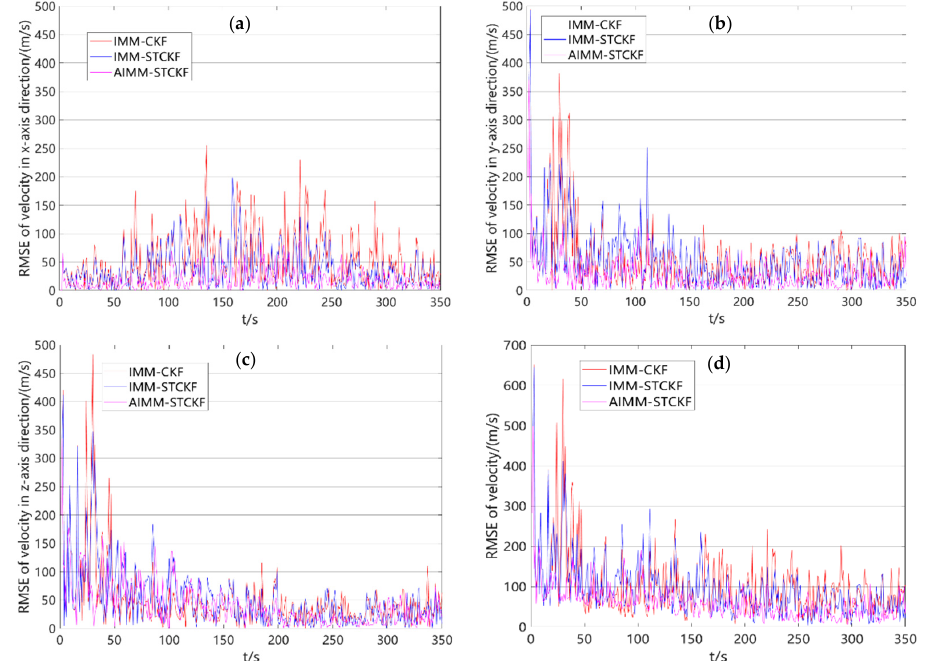
Figure 11. Velocity RMSE of three algorithms: ( a ) RMSE of velocity in the x-axis direction; the RMSE is about 400 m/s; ( b ) RMSE of velocity in the y-axis direction; ( c ) RMSE of velocity in the z-axis direction; ( d ) RMSE of velocity.